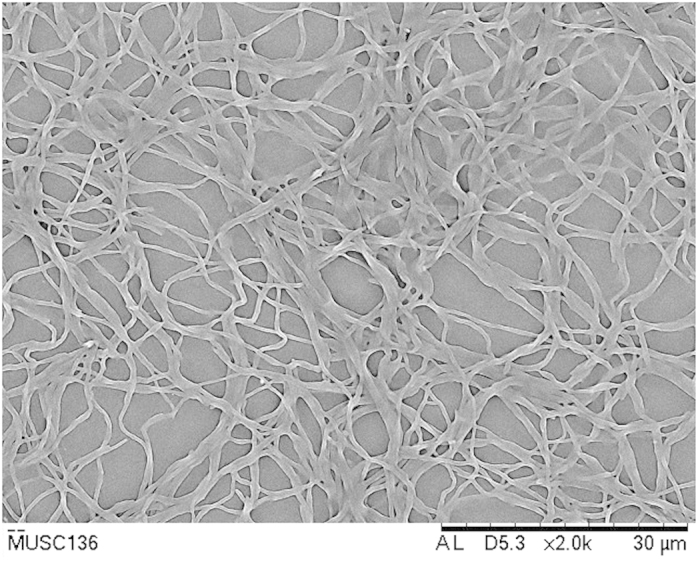
Scanning electron microscope of Streptomyces malaysiense MUSC 136T.